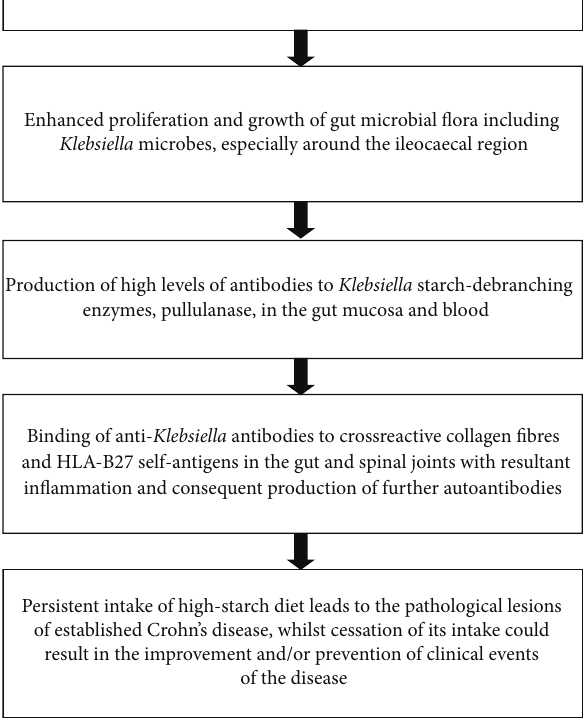
Figure 1: Proposed pathogenetic sequence with the role of Klebsiella and starch consumption in the development of Crohn’s